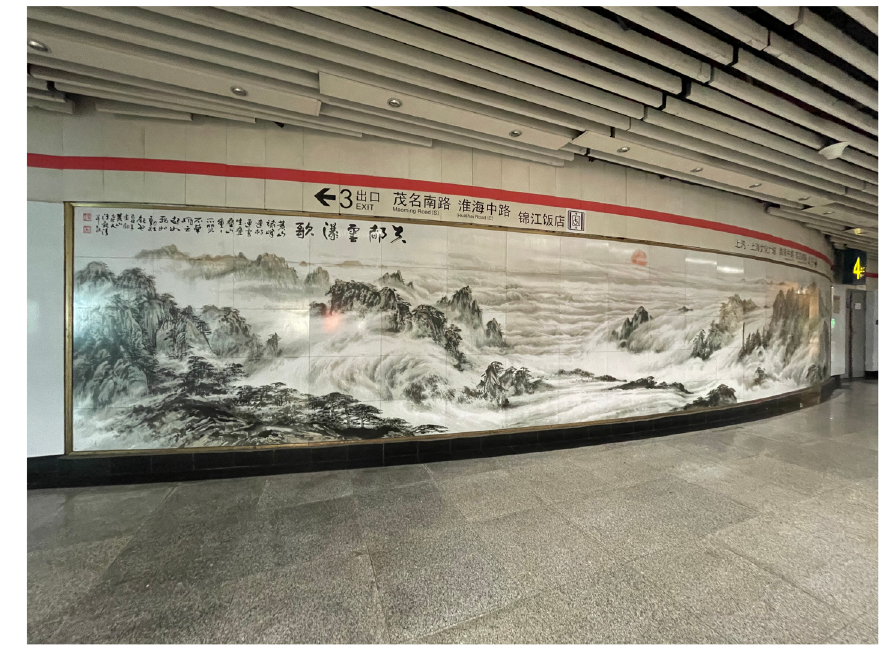
Fig. 6 Mural in South Shaanxi Road Metro Station (line 1). (Source: the author)